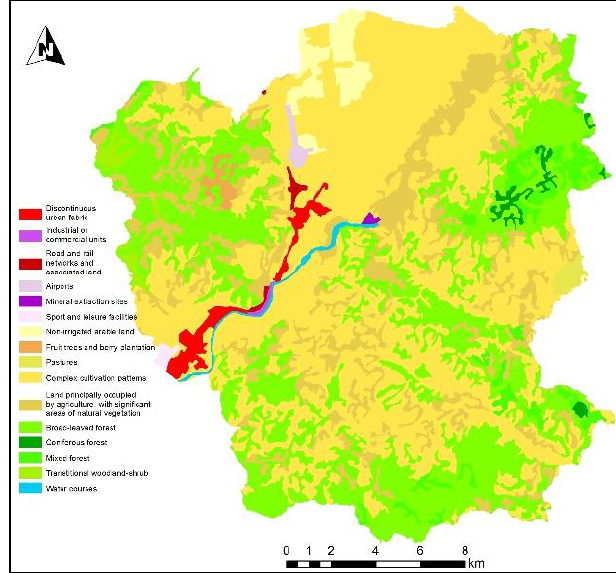
Figure 3 . The spatial distribution of classes in CLC